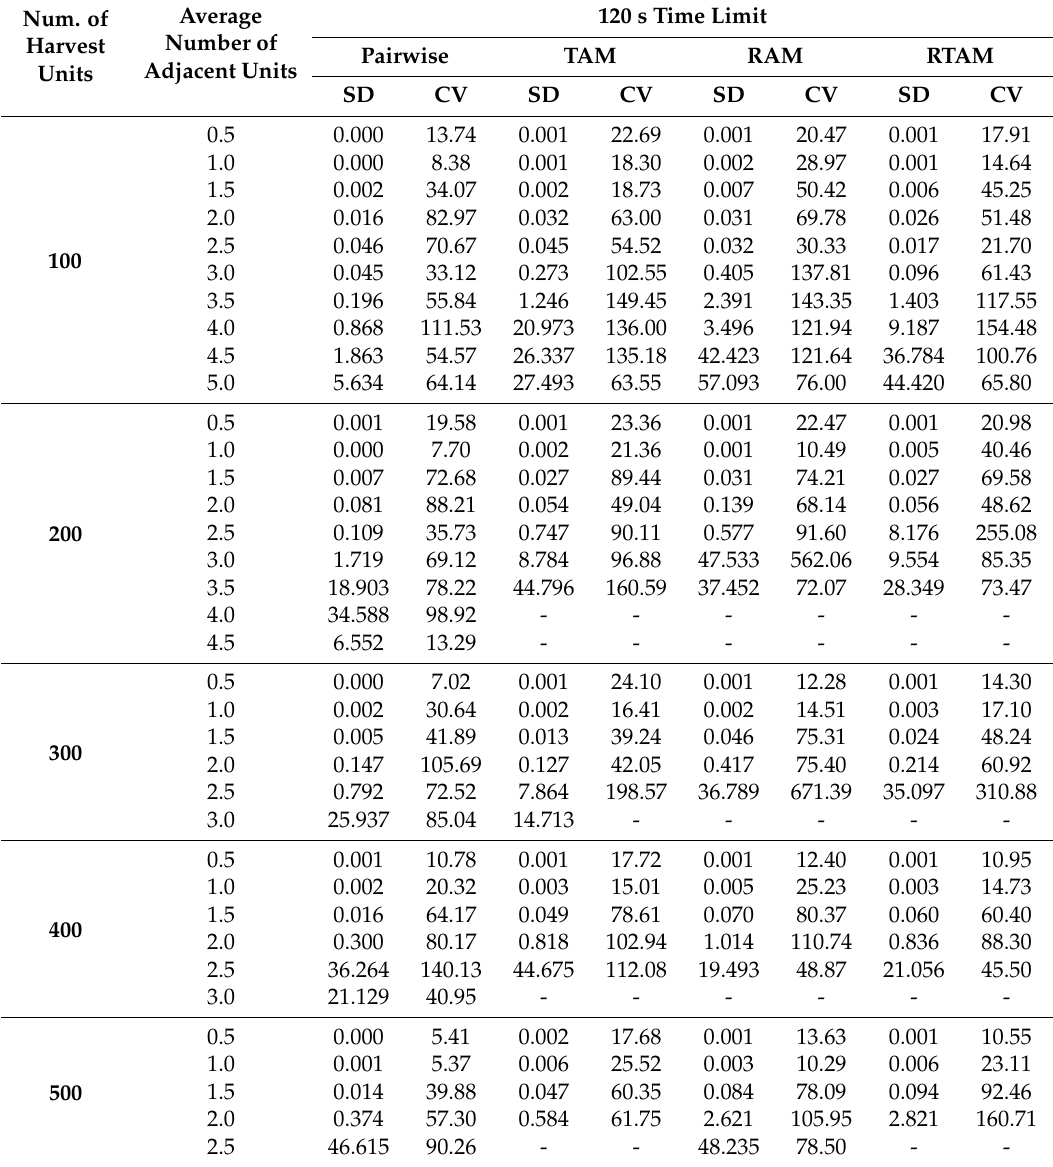
Table 12. Resulting standard deviation (SD) and coefficient of variation (CV) of solving time for 120 s time limit. Num.